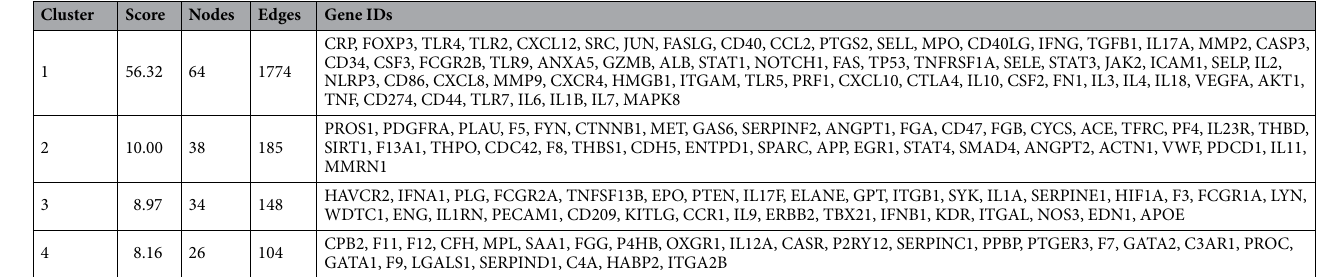
Table 4. Clusters of the disease target PPI